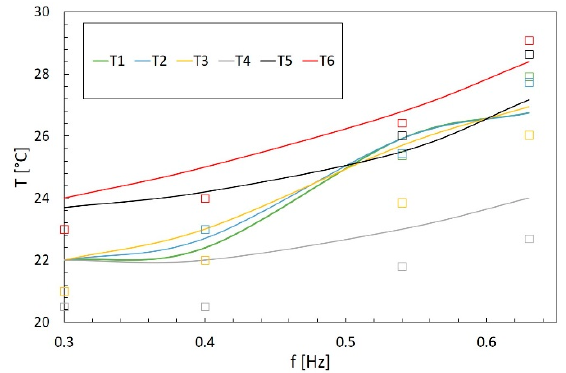
Figure 11. Surface temperature of the MCW in six different representative points as a function of operating frequency: experimental (symbols) vs. simulated (full lines) results.